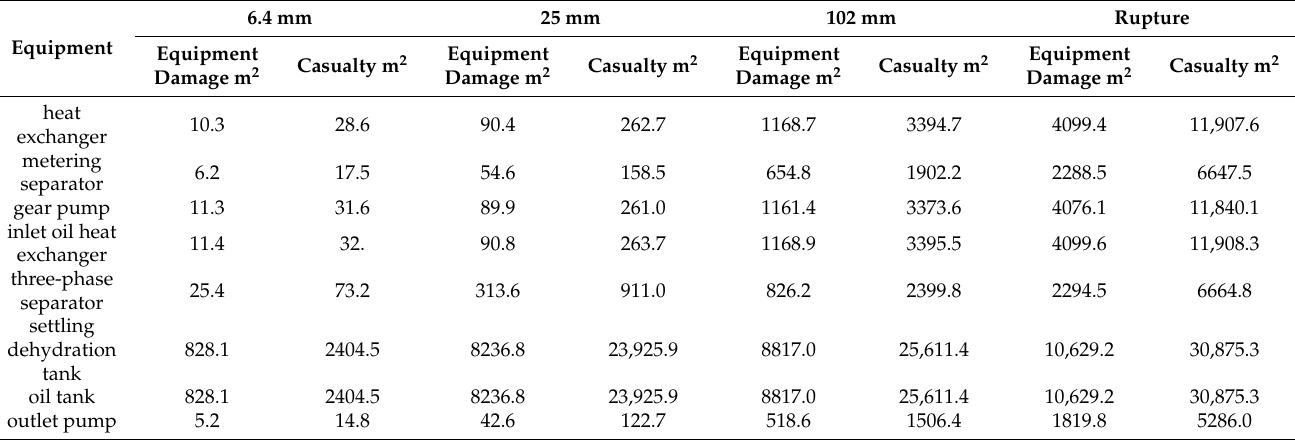
Table 10. Impact area of accident consequence under the specified aperture.